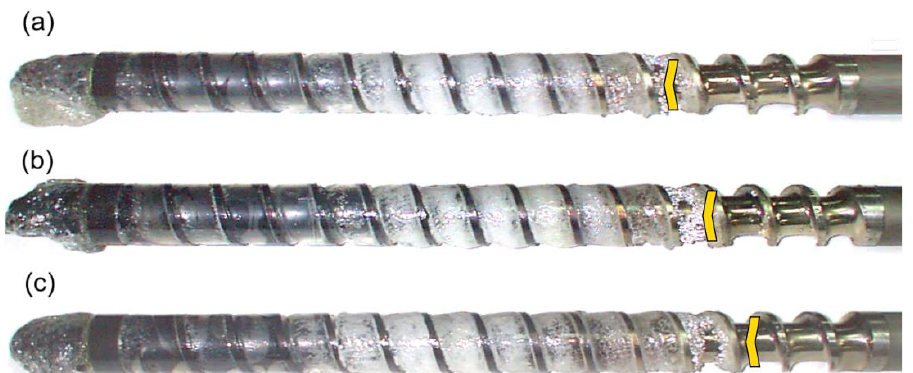
Figure 17. An effect of the back pressure on the polymer flow in the injection molding process at the screw speed N = 100 rpm, and the plasticating stroke h plast = 3 D: ( a ) P back = 0 MPa, ( b ) P back = 2 MPa, ( c ) P back = 3 MPa.